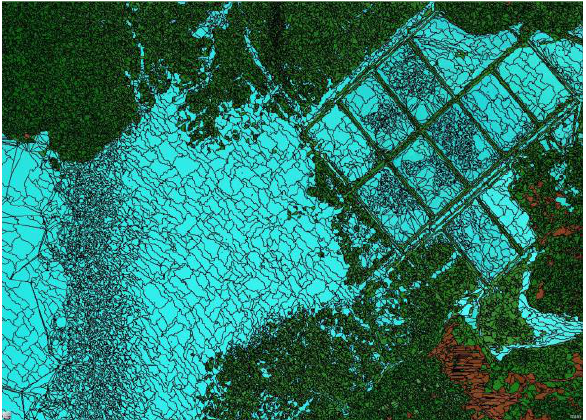
Figure 11a. Image showing segments classified as Water for both sea and aquaculture